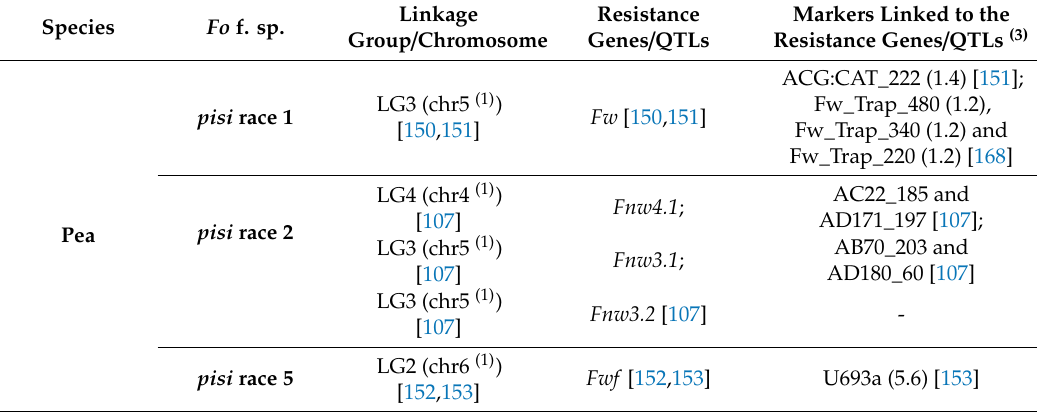
Table 4. Resistance genes and quantitative trait loci (QTLs) against Fo ff . spp. and races infecting legumes, their genetic location (linkage group / chromosome) and linked